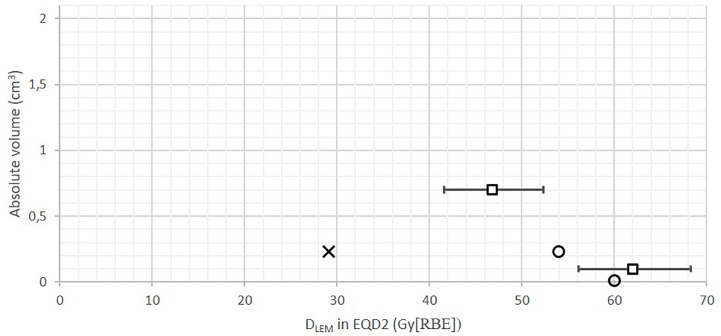
Absolute volume DVH showing old CNAO D
LEM I|1% <30 Gy (RBE) constraint (cross) and the translated Shirai constraints D
LEM I|0.7 cm3 <41 Gy (RBE) and D
LEM I|0.1 cm3 <49 Gy (RBE) (squares, error bars = 95% CI), converted into EQD2 (assuming α/β ratio = 2 Gy) in comparison with the EQD2 constraints applied at HIT as reported by Nikoghosyan et al. (21): D
LEM I|1% <54 Gy (RBE) and D
LEM I|max <60 Gy (RBE) (circles). As an approximation to the absolute volume relating to the D
1% constraints, the median brainstem volume in our data set (26 cm3) was used. The translated constraints are more closely related to the constraints used at HIT than the old CNAO constraint.